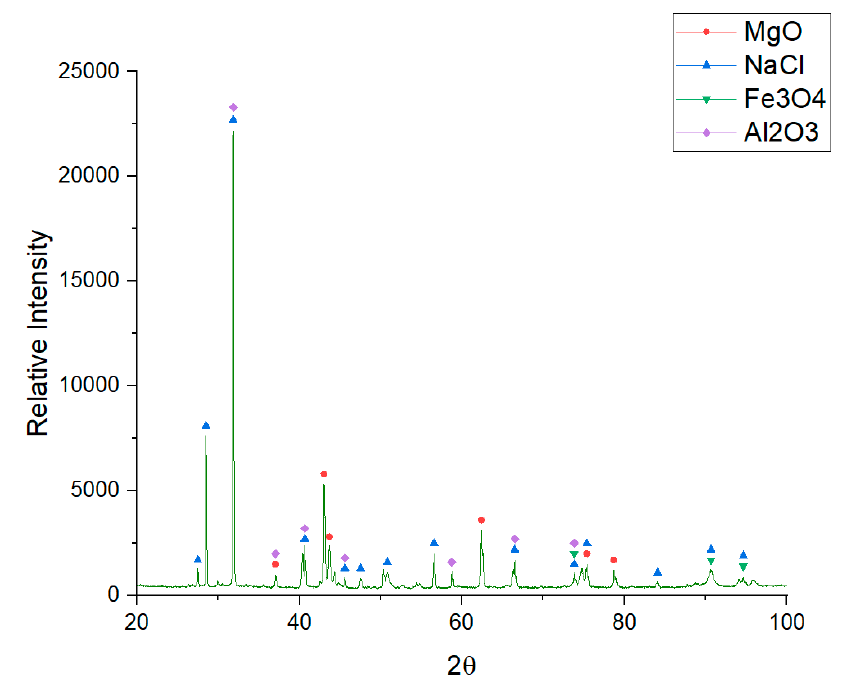
Figure 7. XRD obtained in OCT after 50 h of immersion in chloride molten salt at 720 °C.